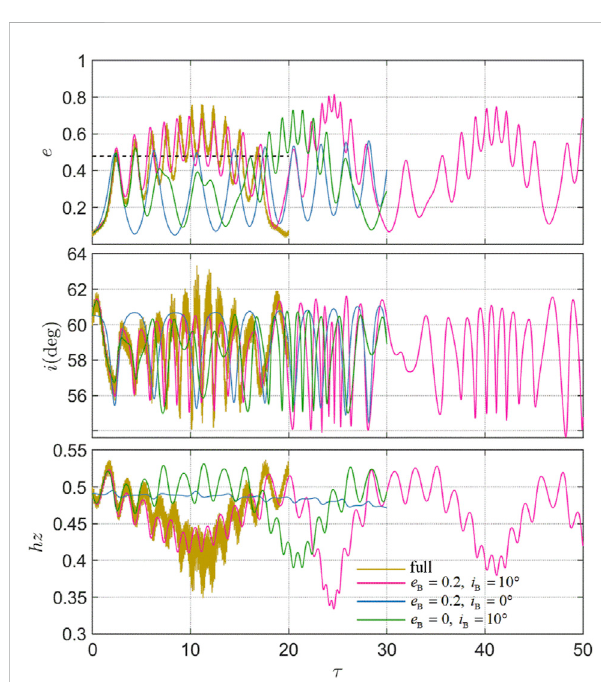
FIGURE 7 Comparisons of the orbital evolution among different combinations of i B and e B . The full model is integrated to 20 scaled time with e B (cid:2) 0 . 2 and i B (cid:2) 10 ° . The other three integrations are all based on the hexadecapole-level model with the scaled integration time: 50 for e B (cid:2) 0 . 2, i B (cid:2) 10 ° , and 30 for e B (cid:2) 0 . 2, i B (cid:2) 0 and e B (cid:2) 0, i B (cid:2) 10 °